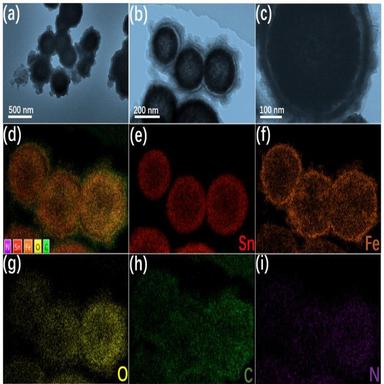
(a, b, c) the TEM images of the SnO2@FeOOH@C nanospheres and element mapping images of (d) survey, (e) Sn, (f) Fe, (g) O, (h) C, and (i) N.